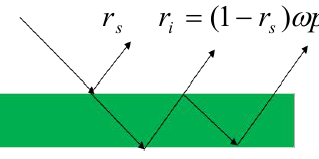
Figure 2. Schematic diagram of the interaction between radiation and